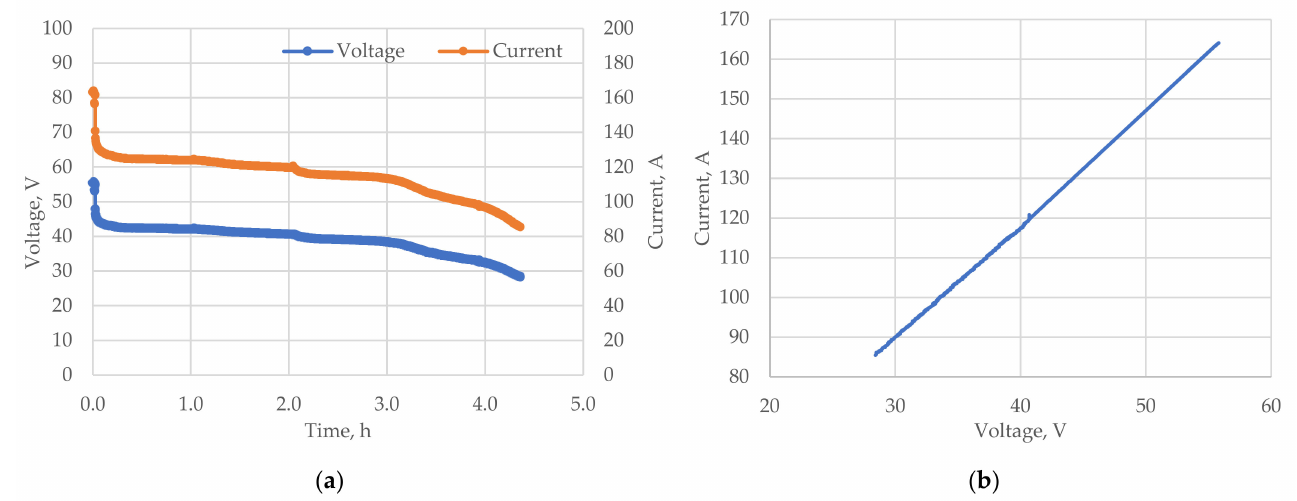
Figure 5. Characteristics of the GEC-VFB-5kW stack: ( a ) discharge; ( b ) I–V